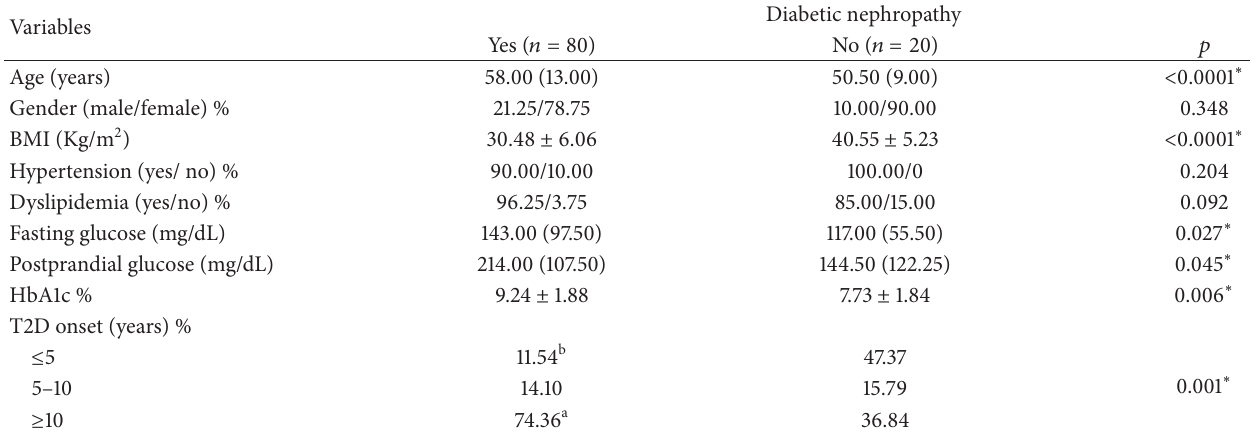
Table 2: Clinical and laboratorial characteristics in T2D patients considering nephropathy (DNP).